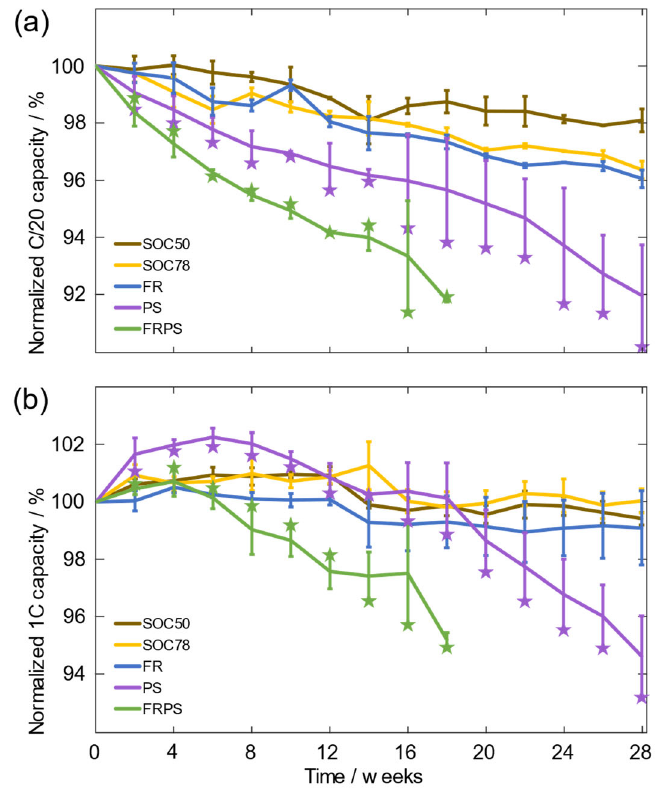
Figure 3. Capacity evolution of the cycle- and calendar-aged cells. An averaged value of the duplicate cells is shown as a line. The FRPSb and PSb cells are marked with a star to show their individual performance. The capacity is measured with ( a ) a C/20-rate current, and ( b ) a higher 1C-rate current.